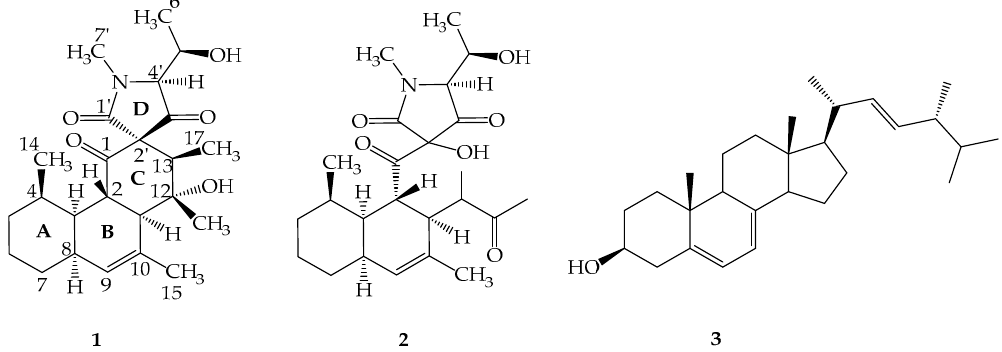
Figure 1. Structures of simplicilone A ( 1 ); simplicilones B ( 2 ); ergosterol ( 3 ).